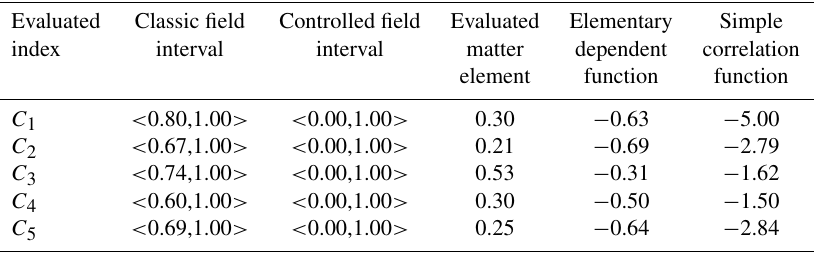
Table 6. Index level results of correlation function under geological conditions criteria for grade I.